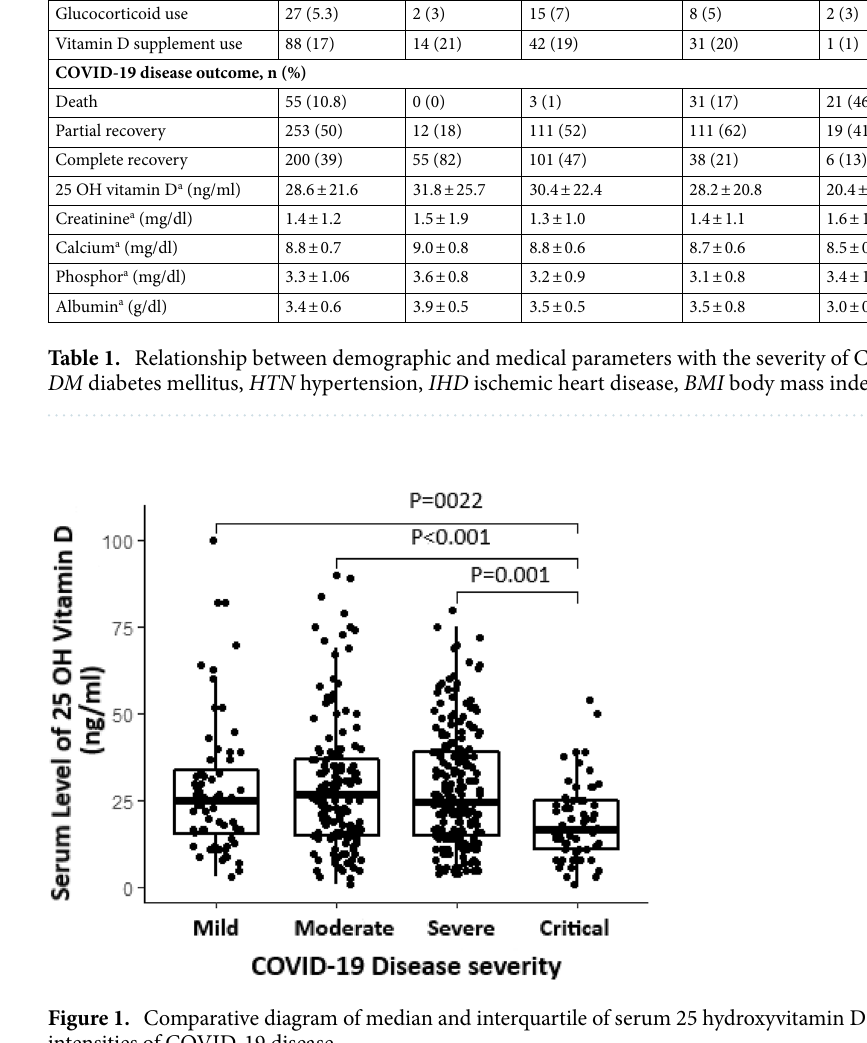
Figure 1 is a box plot showing median and interquartile range of 25(OH)D and different levels of disease severity. The comparisons between median serum vitamin D levels based on severity of disease examined by Mann–Whitney test due to the abnormal distribution of serum 25(OH)D levels. The P-values in Fig. 1 represent the statistically differences between groups. Vitamin D deficiency (25(OH)D < 30 ng/ml) was more common in women than men (69% vs. 56%, P = 0.003) and patients under ICU care than patients admitted in other wards (80% vs. 61%, P = 0.01). The prevalence of vitamin D deficiency and critical illness was lower in people taking vitamin D supplements (P = 0.001 for both). The prevalence of vitamin D deficiency was not different between patients with a history of comorbidities and those without it. Table 2 summarized the patient’s demographic and medical characteristics based on the outcome. The mor- tality is directly related to the patient’s age and the severity of the disease. The mortality of people older than